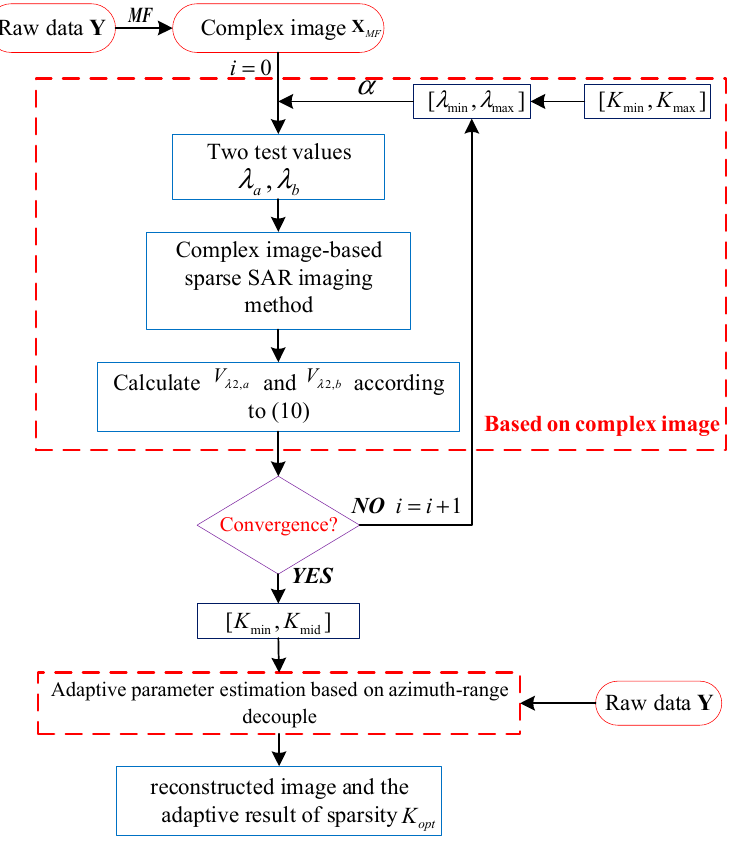
Figure 1. The flowchart of the proposed method.